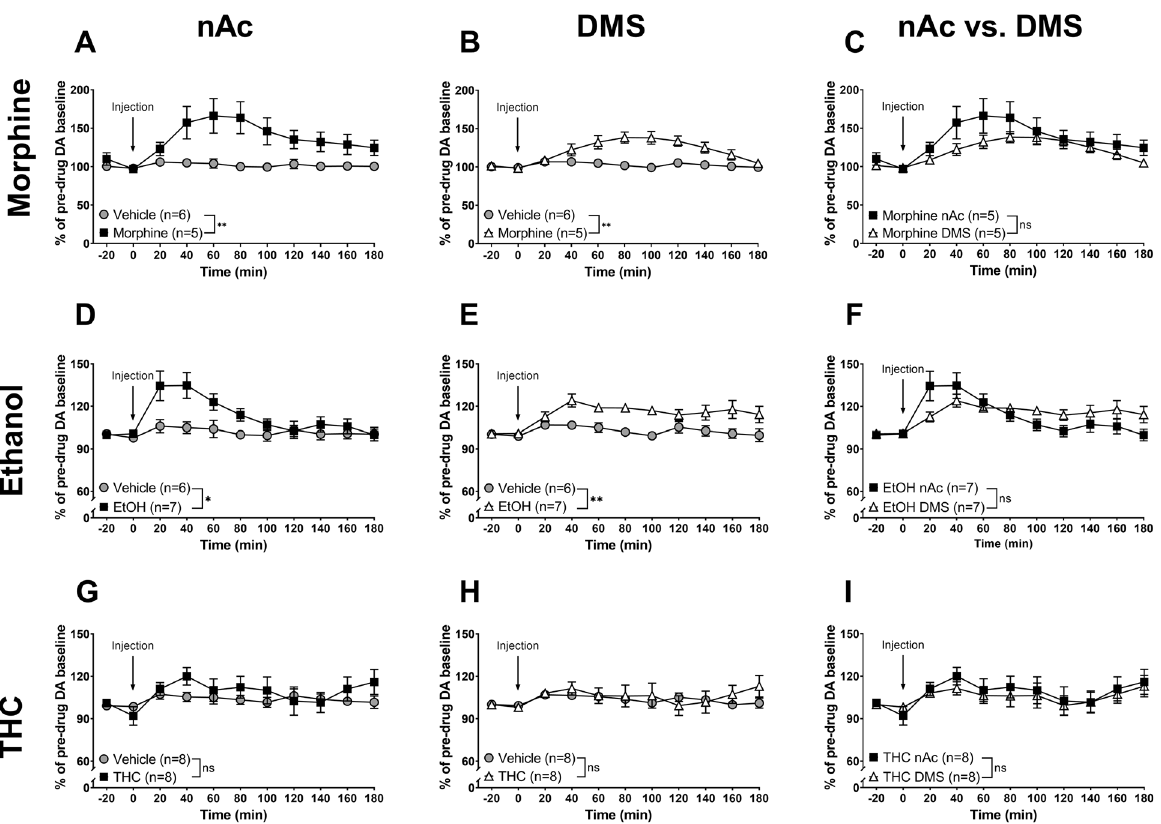
Fig. 3 Qualitative differences in DA-elevating properties of ethanol and morphine in the DMS. A – C Systemic administration of morphine (5 mg/kg i.p.) produced an elevation in extracellular DA in both the nAc and the DMS, however, the effect differed qualitatively over time in the two regions. D – F Ethanol (2.5 g/kg i.p.) signi fi cantly increased extracellular DA levels in both the nAc and the DMS, an increase with a signi fi cantly different pattern in the two regions. G – I THC (3 mg/kg i.p.) failed to produce a signi fi cant increase in striatal DA, both in the nAc and the DMS. All values are presented as means ± SEM. n number of rats. * p < 0.05, ** p <